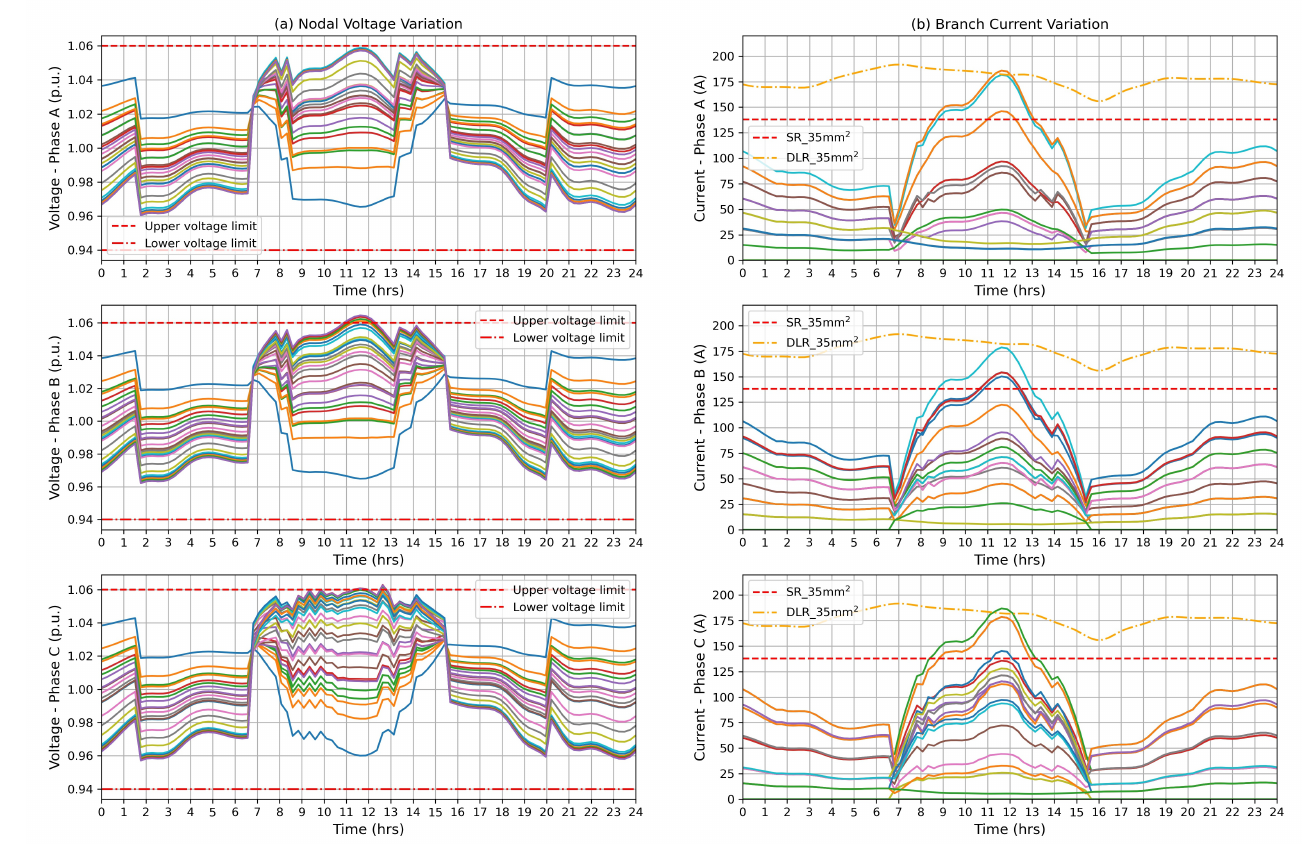
Figure 15. ( a ) Nodal voltage variatio;n and ( b ) branch current variation during the simulation period with DLR and OLTC, RPC coordinated voltage regulation